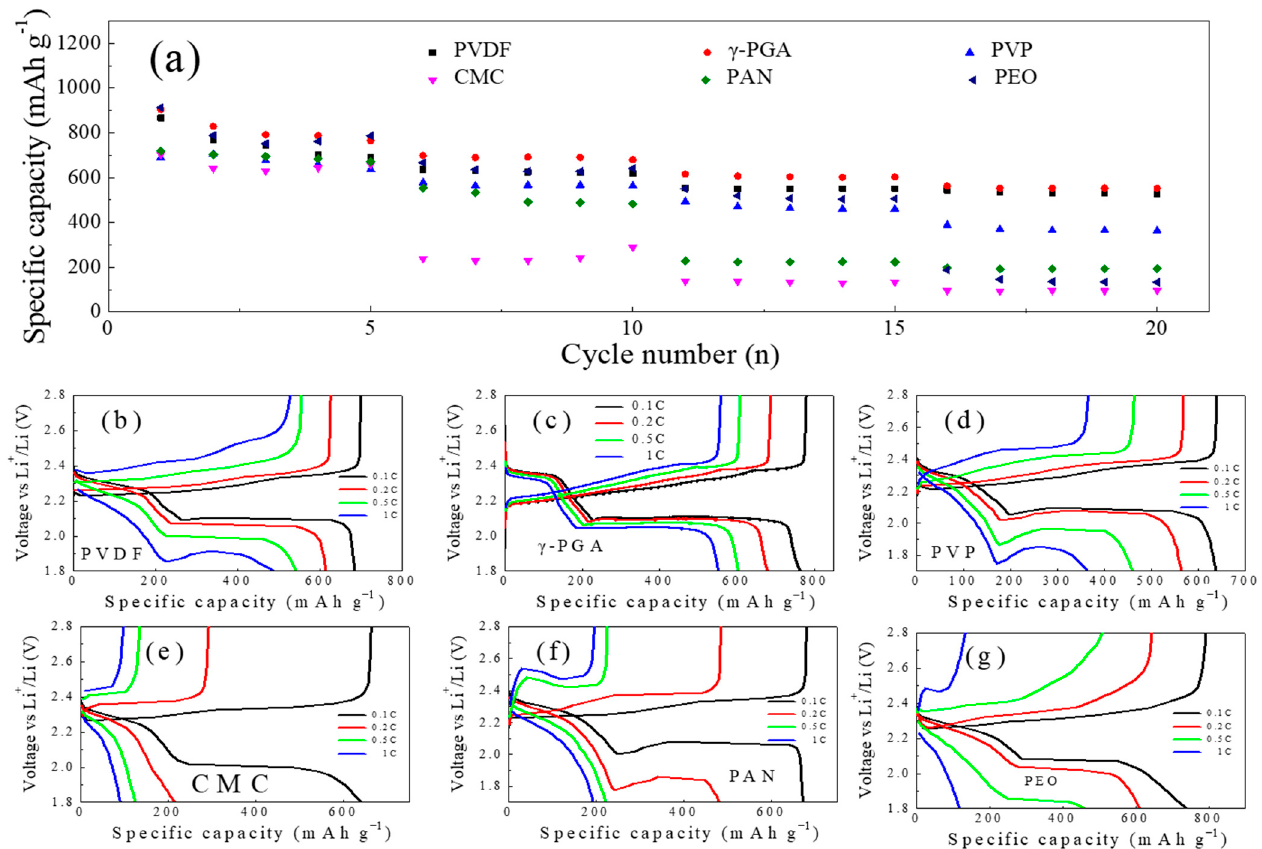
Figure 5. ( a ) Rate performance and the charge/discharge profiles of Li-S batteries with different binders. PVDF ( b ), γ -PGA ( c ), PVP ( d ), CMC ( e ), PAN ( f ), and PEO ( g ) binders.